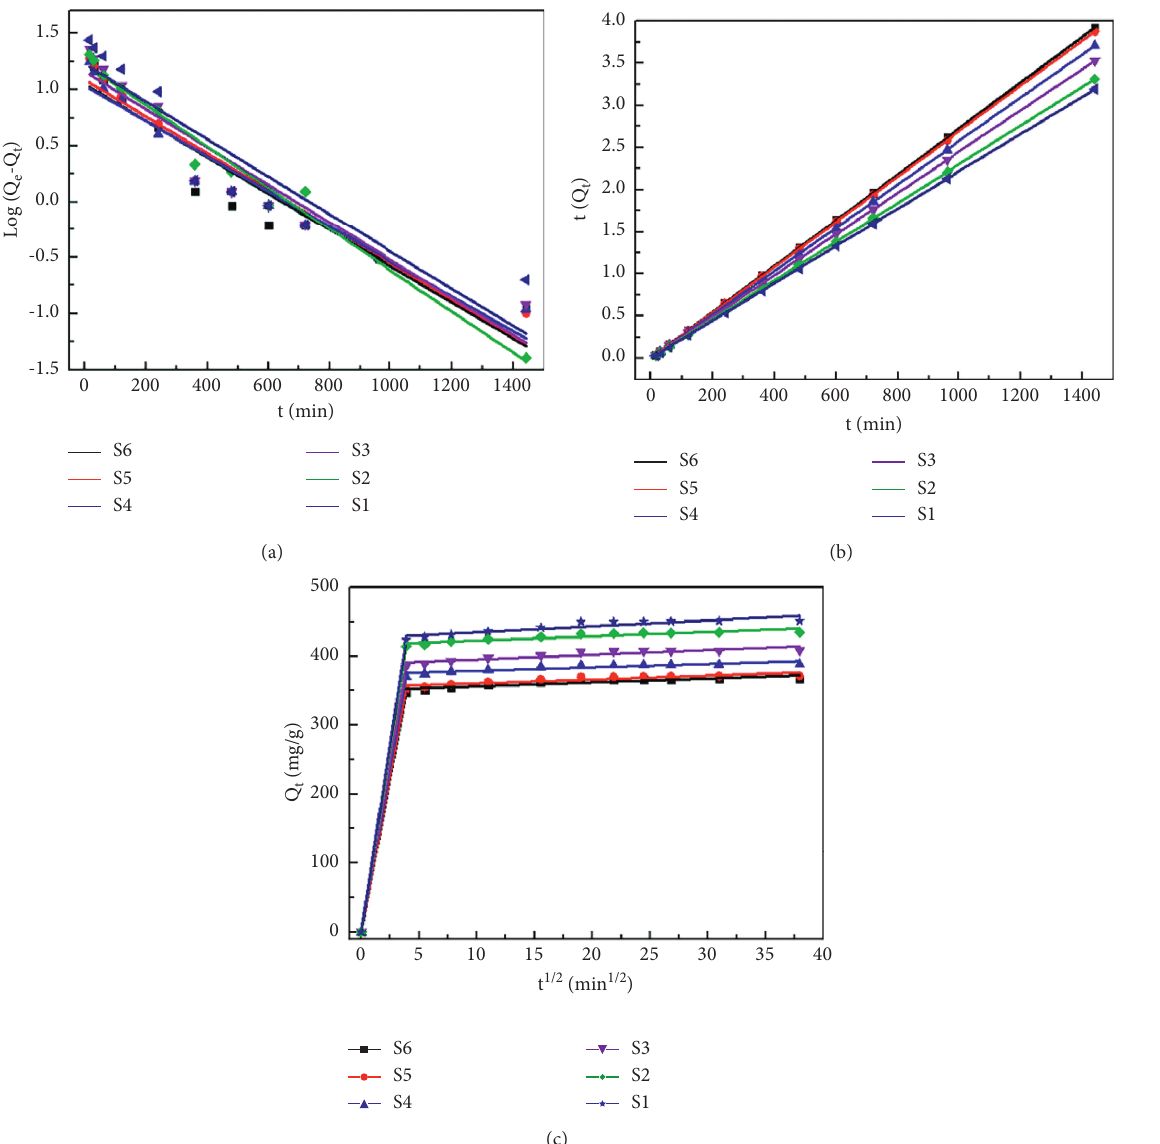
Figure 12: Pseudo-first-order kinetic (a), Pseudo-second-order kinetic (b), and (c) intraparticle diffusion models for adsorption of Cr(VI) onto various Fe 3 O 4 /PPy nanotubes. Table 2: Pseudo-first-order and pseudo-second-order kinetic parameters for adsorption of Cr(VI) onto various Fe